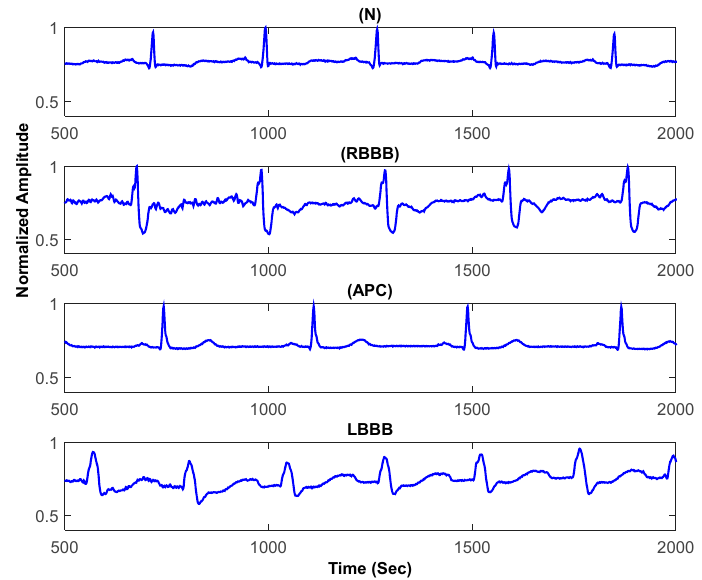
Figure 7. Examples of pre-windowed ECG signals.